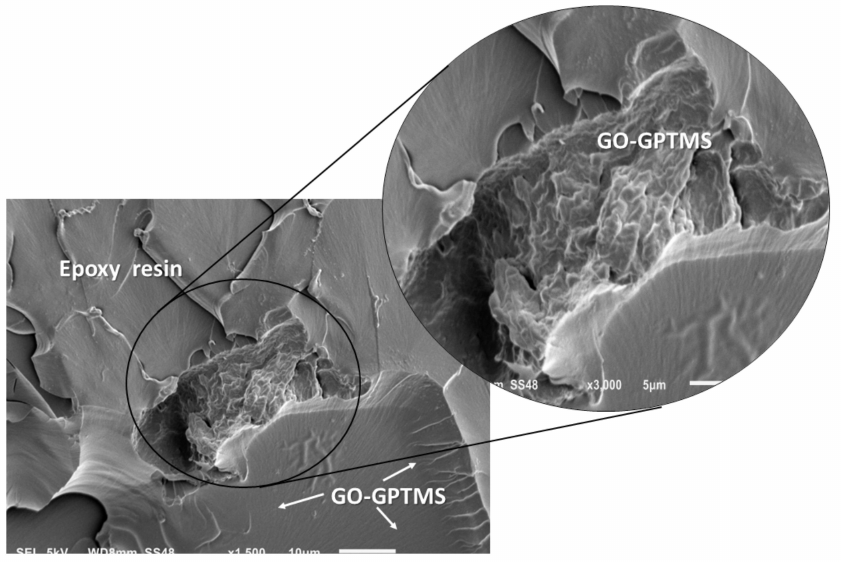
Figure 10. SEM micrographs (150 × ), (500 × ); ( A , D ) GO2-GPTMS/epoxy-1, ( B , E ) GO2-GPTMS/epoxy- 2, and ( C , F ) GO2-GPTMS/epoxy-3.